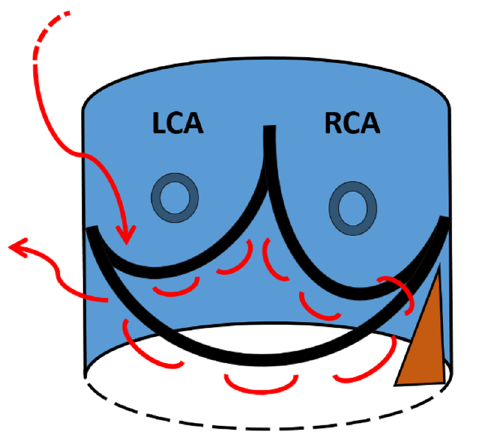
Figure 2. A schematic view of the 3-0 polypropylene purse string suture (red line) seen from the surgeon’s point of view. LCA = left coronary artery; RCA = right coronary artery. The brown triangle identifies the fibrous trigon.